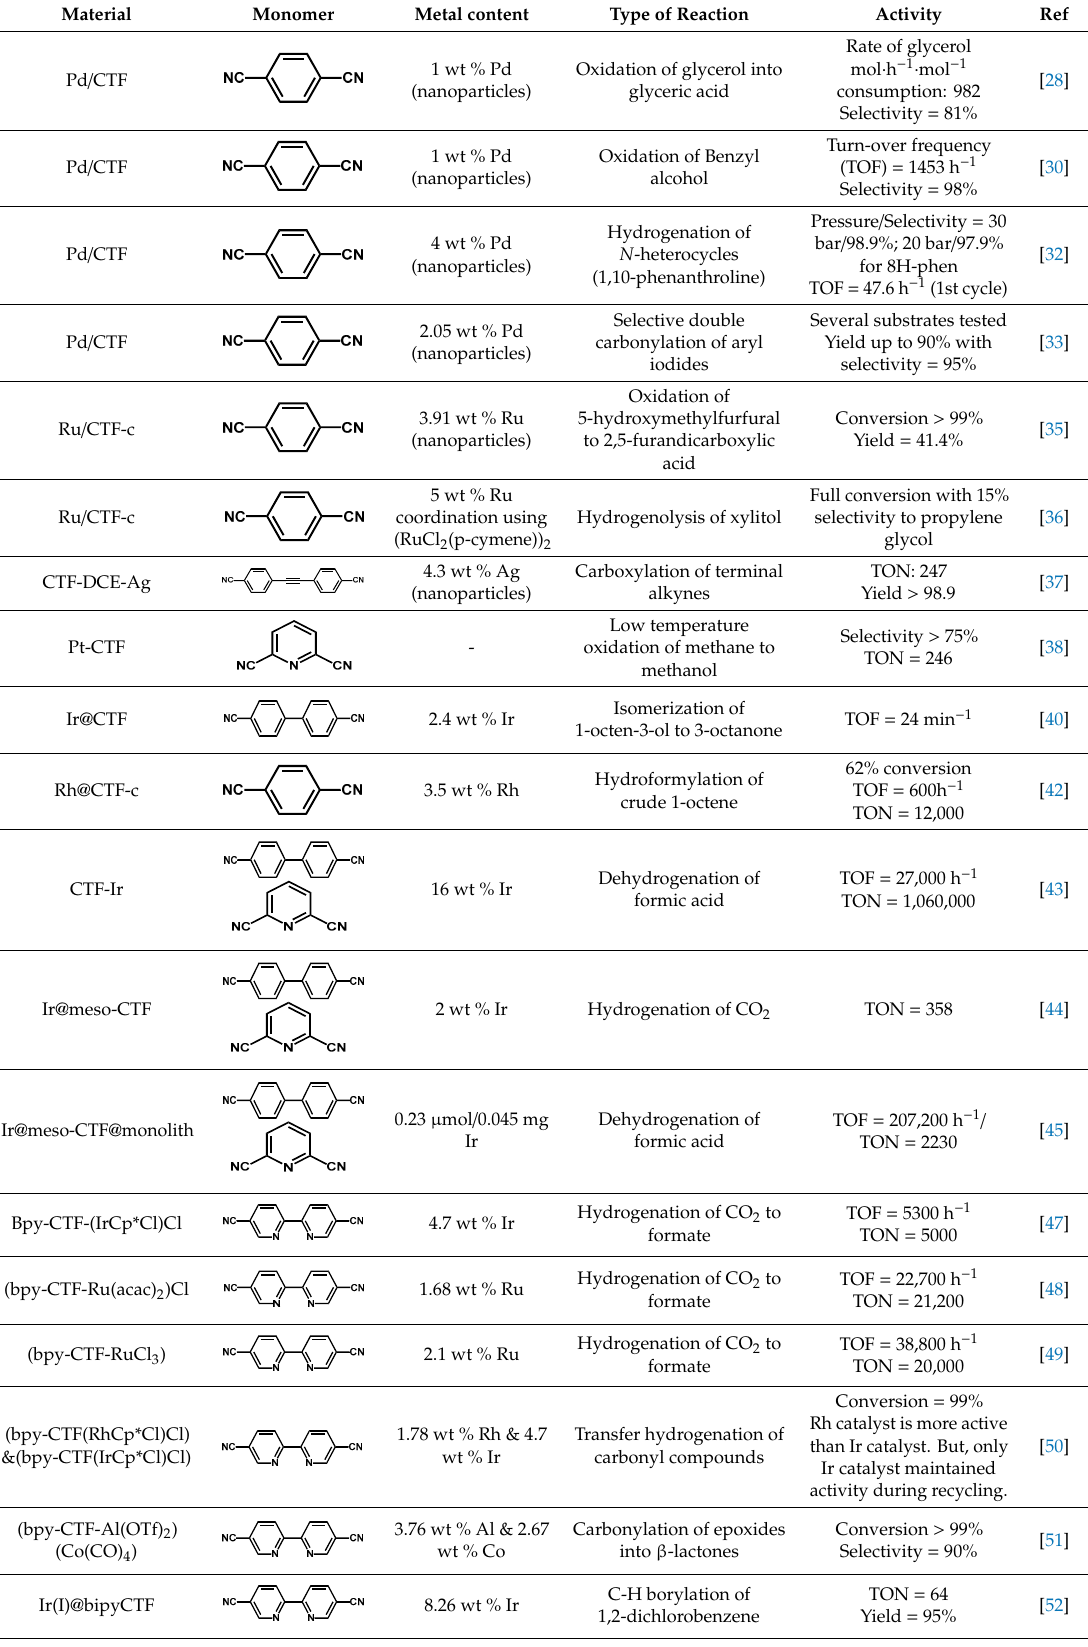
Table 1. Summary of various catalytic reactions performed by utilizing CTFs.